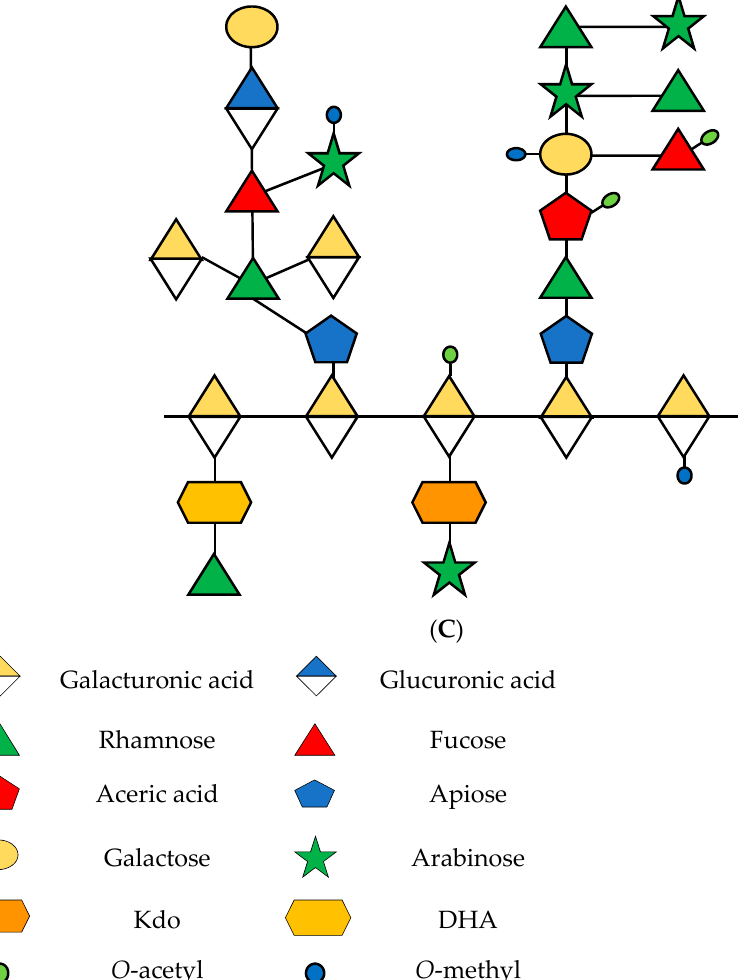
Figure 1. Schematic representation of principal pectins in the primary cell wall of plants. ( A ) HG; ( B ) RG-I and ( C ) RG-II. Sugars are represented according to the Symbol Nomenclature for Glycans (SNFG) [20]. Based on [16,21,22].